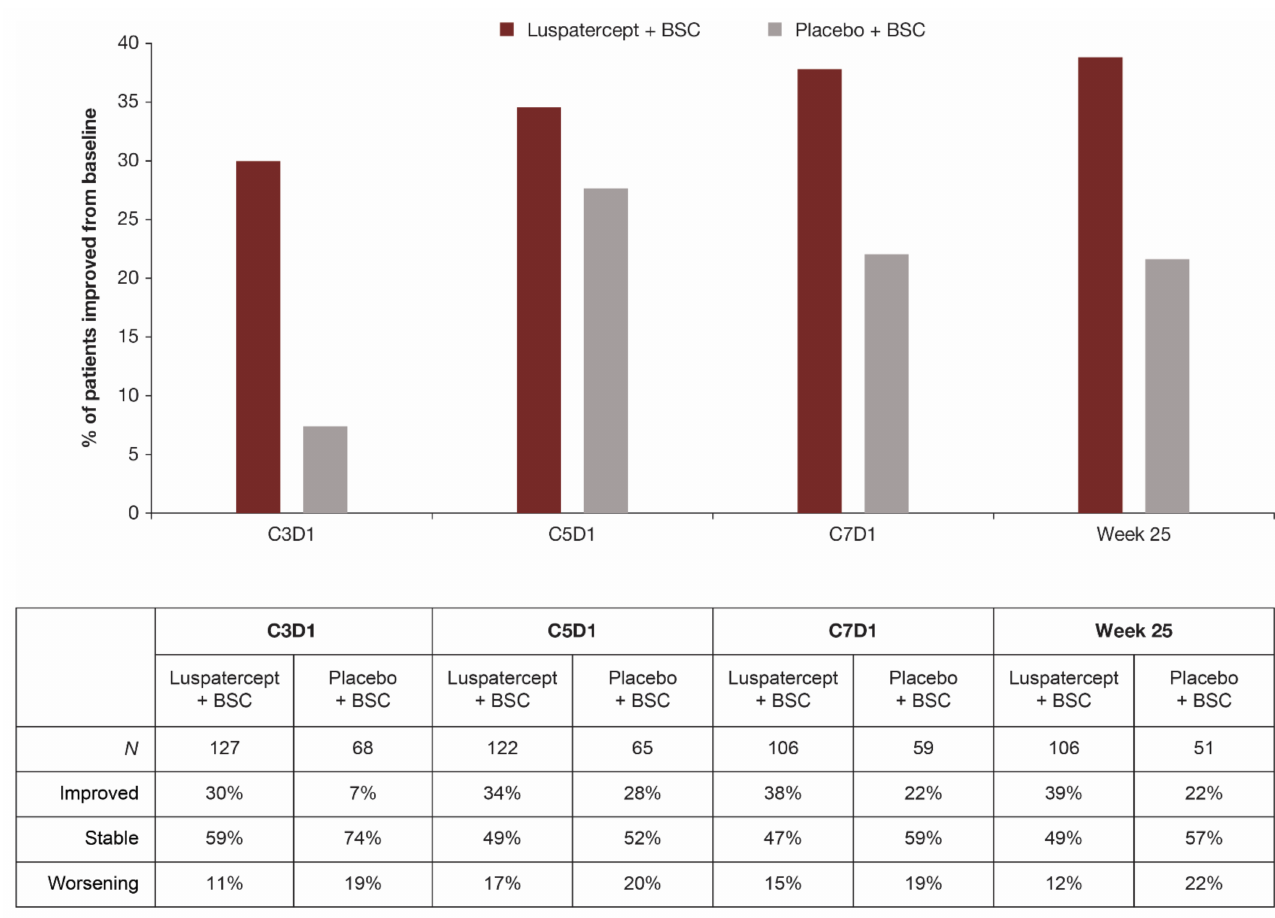
Figure 4. Patient-reported impact of transfusion burden by QOL-E from treatment initiation through week 25. Question from the QOL-E instrument: What effect of the disease disturbs your daily life? Being dependent on transfusions; response options: “No, not at all”, “A little bit”, or “Yes, extremely”. Responses at each timepoint were compared with responses at baseline to assess if patients had improved, remained stable, or experienced worsening. BSC, best supportive care; C3D1, cycle 3 day 1 (and similarly for C5D1 and C7D1); MDS, myelodysplastic syndromes; QOL-E, Quality of Life Assessment in MDS